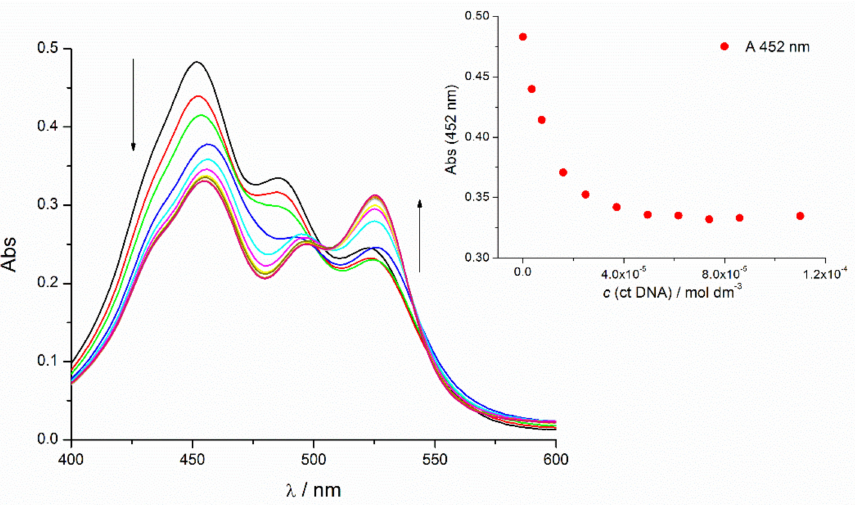
Figure 1. UV/Vis titration of 4e ( c = 9 × 10 − 6 mol dm − 3 , sodium cacodylate buffer, pH = 7, I = 0.05 mol dm − 3 ) with ct-DNA; inset: changes in the UV/Vis spectra of 4e at λ max = 452